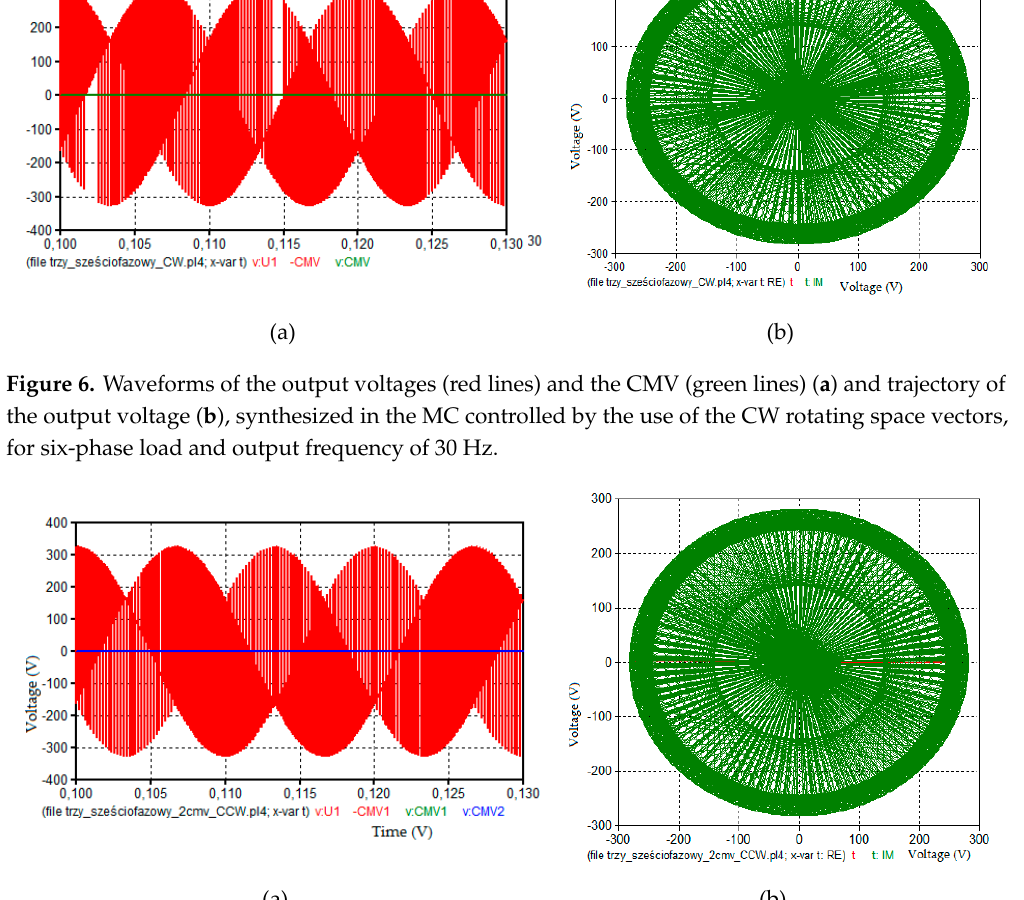
Figure 7. Waveforms of the output voltages (red lines) and the CMV1 (green colour), and the CMV2 (blue line) ( a ) and trajectory of the output voltage ( b ), synthesized in the MC controlled by the use of the CCW rotating space vectors, for six-phase load with two star points and output frequency of 30 Hz.